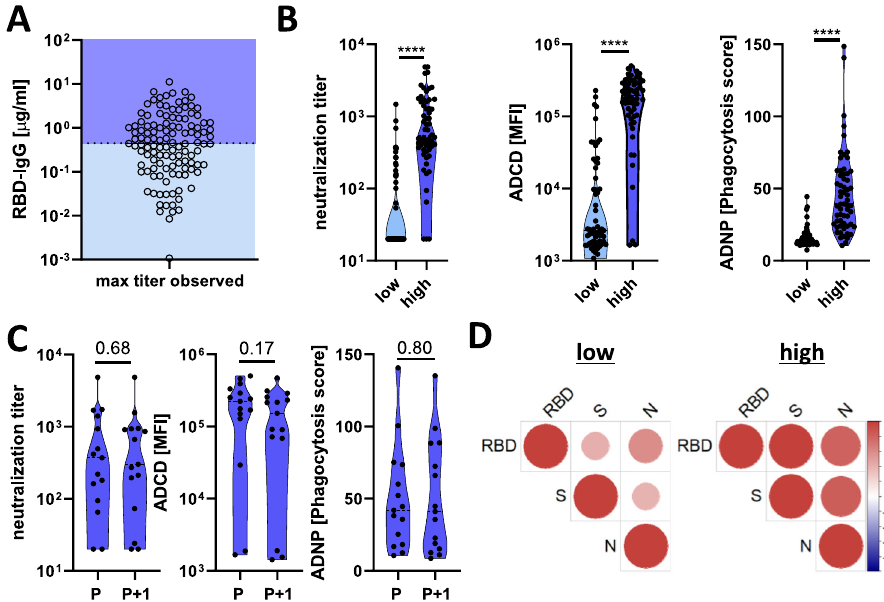
Fig. 3 A discrete titer cut-off tracks with functional SARS-CoV-2 humoral and T cell immunity. A The dot plot shows the distribution of study maximum observed antibody titers (highest titer per individual observed in this study) across the cohort, split based on median titers. Dark blue shading indicates all individuals above the median and the light blue shows all the individuals below the median ( n total = 120; n low = 60, n high = 60). B The violin plots show the distribution of neutralizing antibody titers (dilution factor, left), antibody-dependent complement deposition (ADCD, mean fl uorescence intensity, middle), and antibody-dependent neutrophil phagocytosis (ADNP, phagocytosis score, right)( n low = 60, n high = 60) against SARS-CoV-2 S. C The violin plots show the neutralization levels, ADCD, and ADNP ( n = 15) from the maximum observed titers to the next timepoint ( P + 1) in a subset of individuals in the high titer group. D The correlation heat maps (Spearman-correlation) show signi fi cant correlations ( p < 0.05) between RBD, Spike (S), and Nucleocapsid (N) titers in the high titer (right; n = 15) and low titer (left; n = 26) groups. Statistical differences between two groups were assessed with a two-sided non- parametric Mann – Whitney test in ( B ) and paired Wilcoxon-test in ( C ). **** p < 0.0001 or exact p -values for not signi fi cant comparisons. Source data are provided as a Source Data fi thresholds for each antibody effector function that may ultimately with durable functional humoral immune responses to RBD and de fi ne quantitative antibody functional correlates of immunity in other SARS-CoV-2 antigens. future large-scale sero-surveillance cohorts. Together, these data The absence of high binding, neutralization, or antibody indicate that antibodies to other SARS-CoV-2 antigen speci fi cities effector function does not ultimately rule out protection from re- may not compensate for low RBD-speci fi c functional antibody infection, and speculation has emerged about the potential role of levels. Rather, it appears that a distinct titer threshold may track T cells, rather than antibodies, as critical correlates of immunity